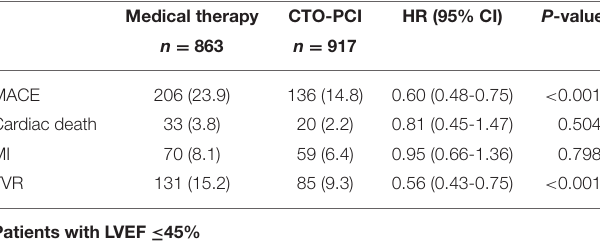
TABLE 7 | Clinical outcomes of patients with and without left ventricular systolic dysfunction stratified according to medical therapy or initial CTO-PCI. Patients with LVEF > 45% Medical therapy